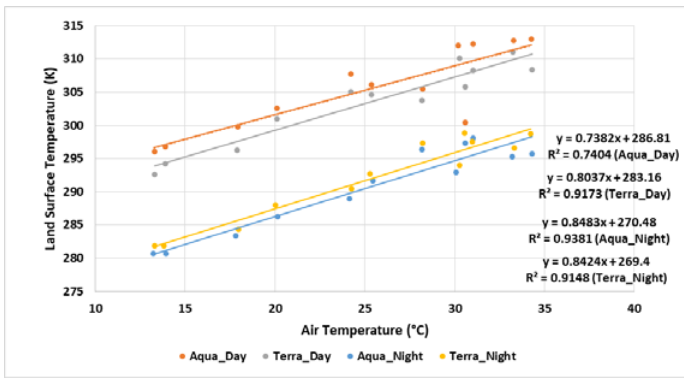
Figure 5. The correlation between air temperature and land surface temperature for the Shadipur site